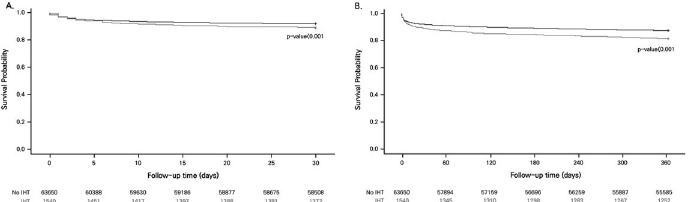
Fig 3. Survival curve of the 30-day and 1-year mortality in ST-segment elevation myocardial infarction patients grouped according to the inter-hospital transfer status after the standardized inverse probability of treatment weighting. A: Adjusted survival curve of the 30-day mortality, B: Adjusted survival curve of the 1-year mortality. Abbreviations: IHT, Inter-hospital transfer.